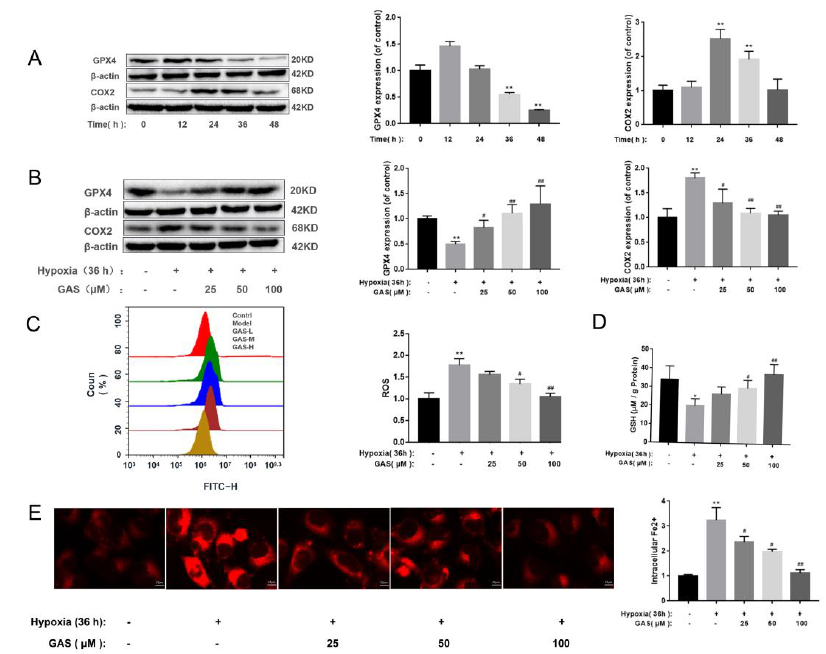
Figure 3. GAS inhibits hypoxia-induced ferroptosis in HT22 Cells. ( A ), Western blot showing the levels of GPx4 and COX2 at different time points of hypoxia in HT22 cells ( B ), HT22 cells were pretreated with GAS for 1 h and cultured in hypoxia for 36 h, and then, the expressions of GPx4 and COX2 were detected by Western blotting ( C ), ROS levels were measured by flow cytometry ( D ), detection of GSH content by ELISA ( E ), When HT22 cells were cultured under hypoxia for 36 h in the presence or absence of GAS, the intracellular Fe 2+ levels were measured by immunofluorescence microscopy using FerroOrange. * p < 0.05, ** p < 0.01 versus control, # p < 0.05, ## p < 0.01 versus hypoxia.